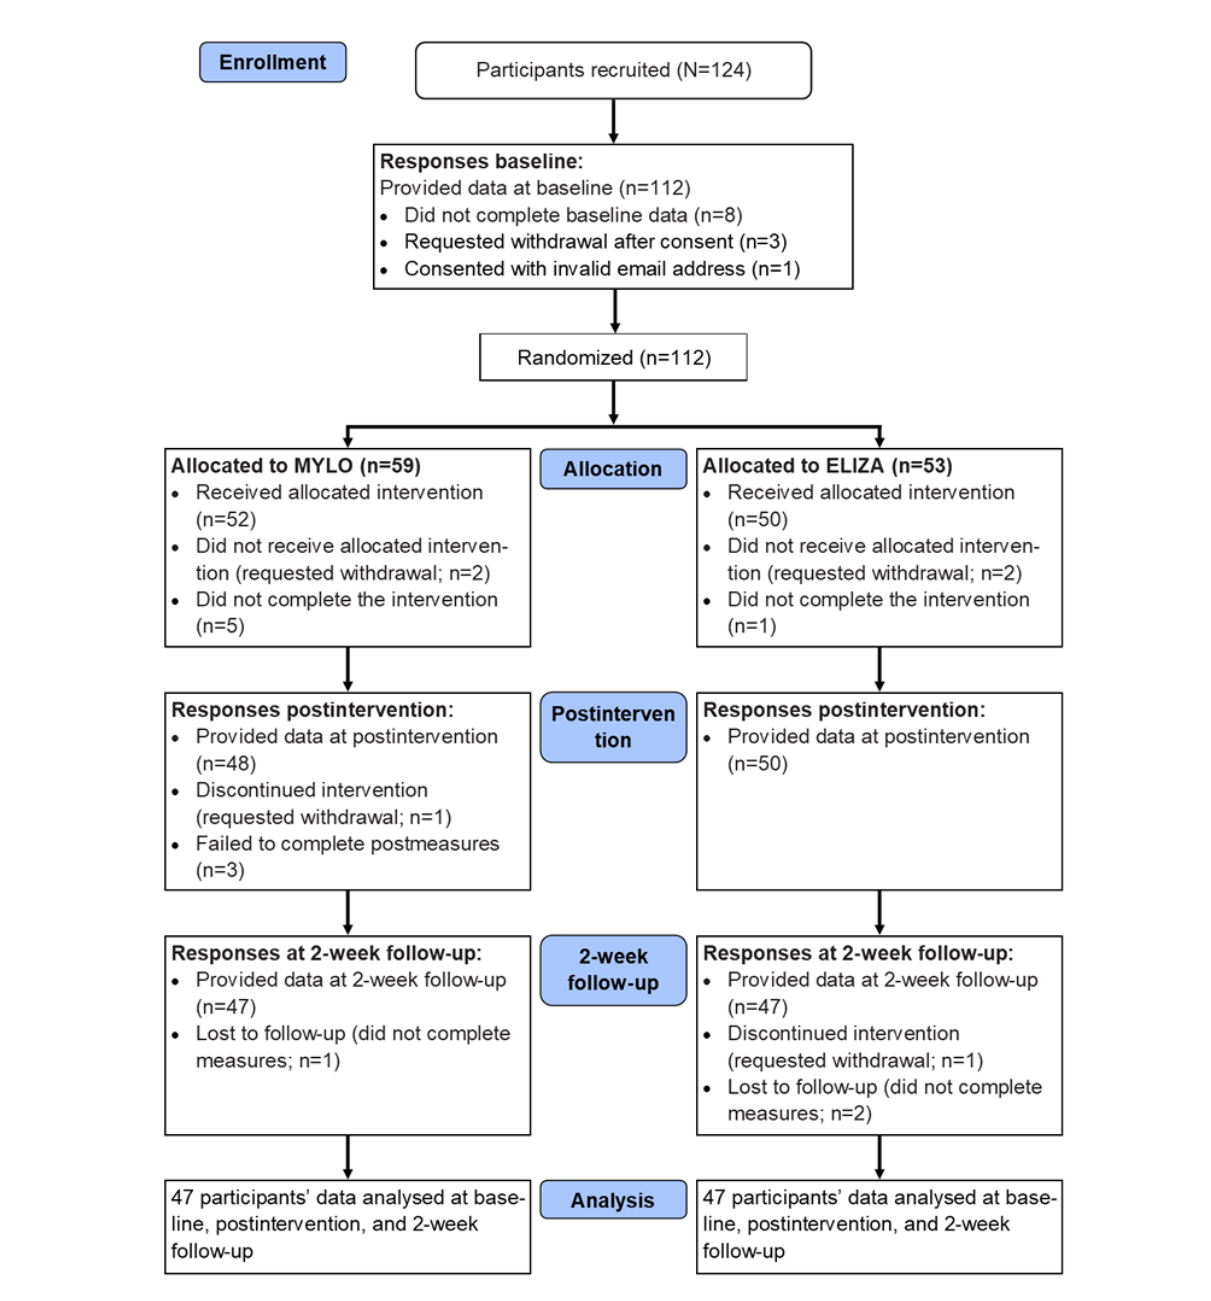
Figure 1. Participant flow diagram. MYLO: Manage Your Life